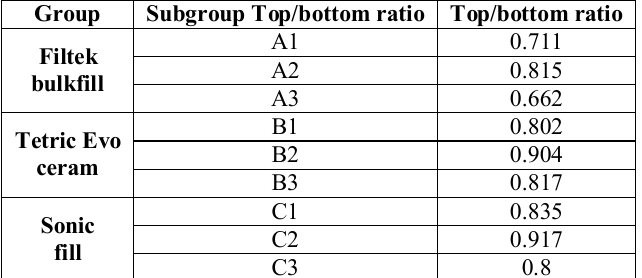
Table 7: Bottom/ top ratio for all groups